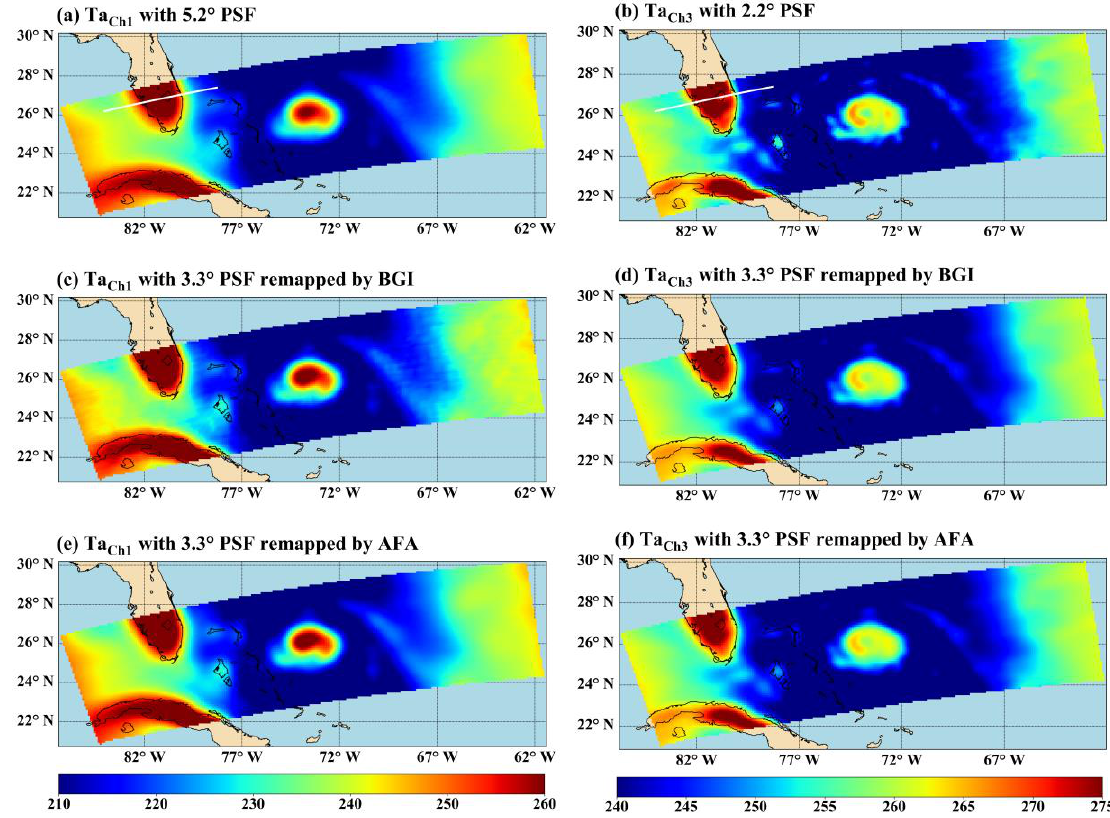
Figure 10. Application of the BGI and the AFA to real ATMS observations for resolution enhancement (left) and degradation (right). ( a ) Raw observations of ATMS channel 1, and ( c ) BGI and ( e ) AFA remapping results; ( b ) raw observations of ATMS channel 3, and ( d ) BGI and ( f ) AFA remapping results. The white lines in ( a , b ) indicate the location of the Ta cross-sections shown in Figure 11. Units are K.